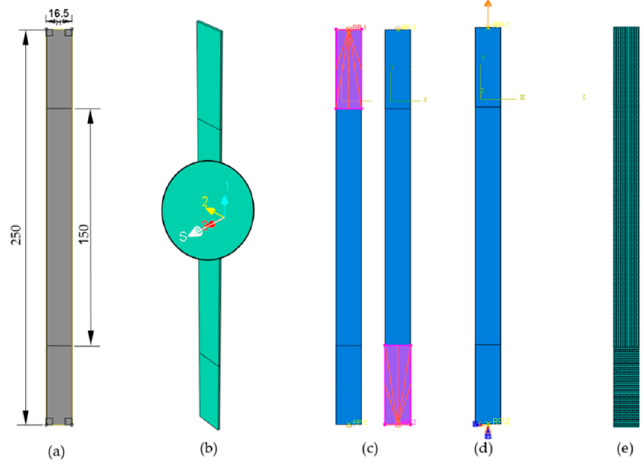
Figure 4. FEA model: geometry ( a ), 0° fiber orientation ( b ), boundary conditions ( c , d ), meshing ( e ).